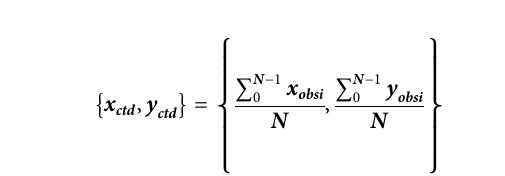
Frontiers in Robotics and AI |